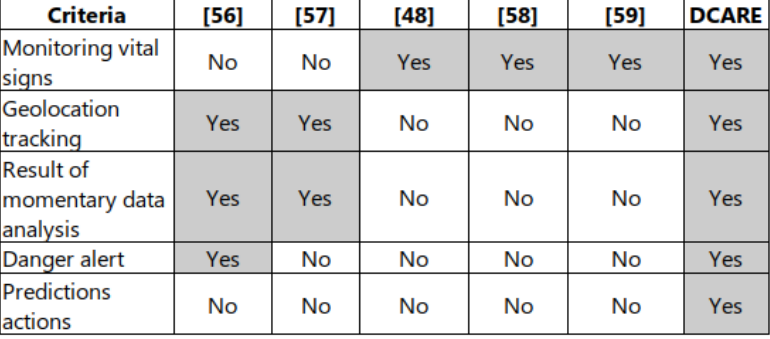
Figure 1. Comparison between related